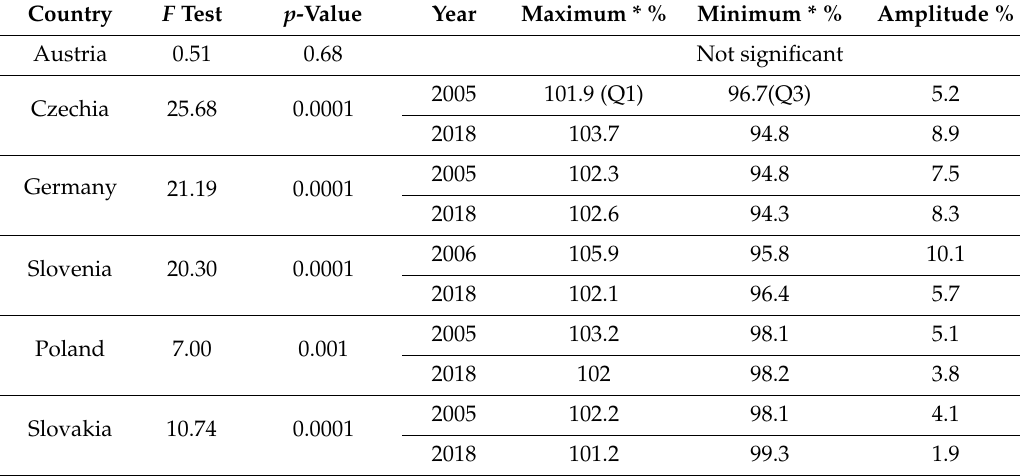
Figure 7. Irregular changes in beech roundwood prices in selected European countries in 2005–2018. In Austria, beech roundwood prices were much higher than the mean price in the Central European market. Prices fluctuated around a stable level without a clear long-term trend, with small amplitudes of cyclical variability. The largest amplitude of irregular changes (8.2%) was found in Q1 2015. The seasonal component did not reach statistical significance (Table 2). Table 2. Statistical parameters of seasonal variability of beech roundwood prices in selected European countries in 2005–2018.